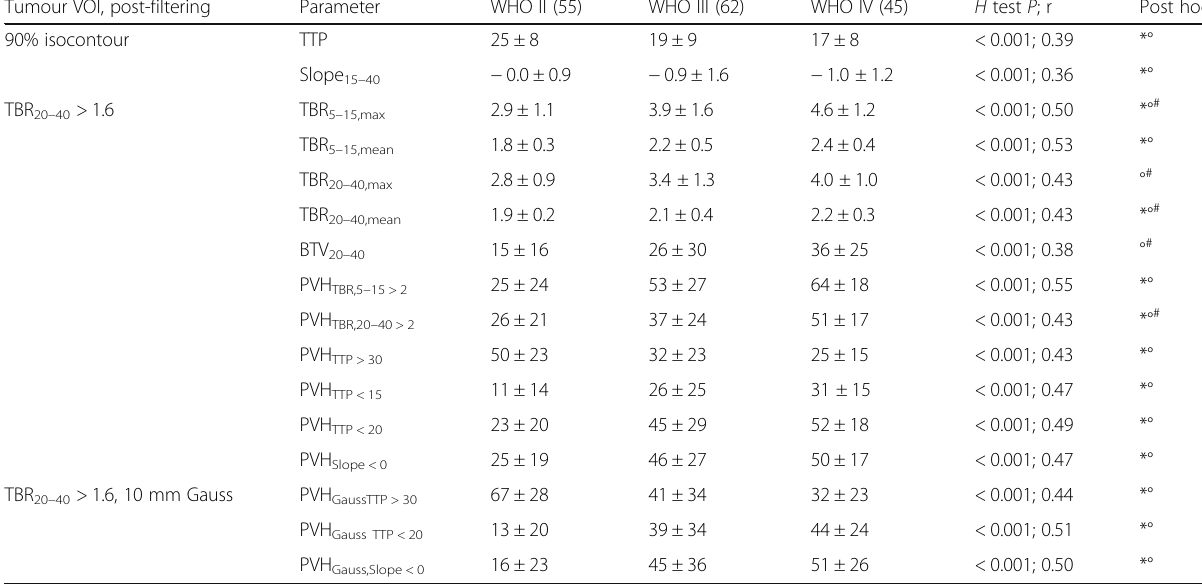
Table 2 TTP (units: min p.i.), Slope 15 – 40 (units: SUV/h), TBR (units: 1), and BTV 20 – 40 (units: mL) from VOI-based analysis and voxel-wise PVH (units: %) separated according to histologic grading Tumour VOI,